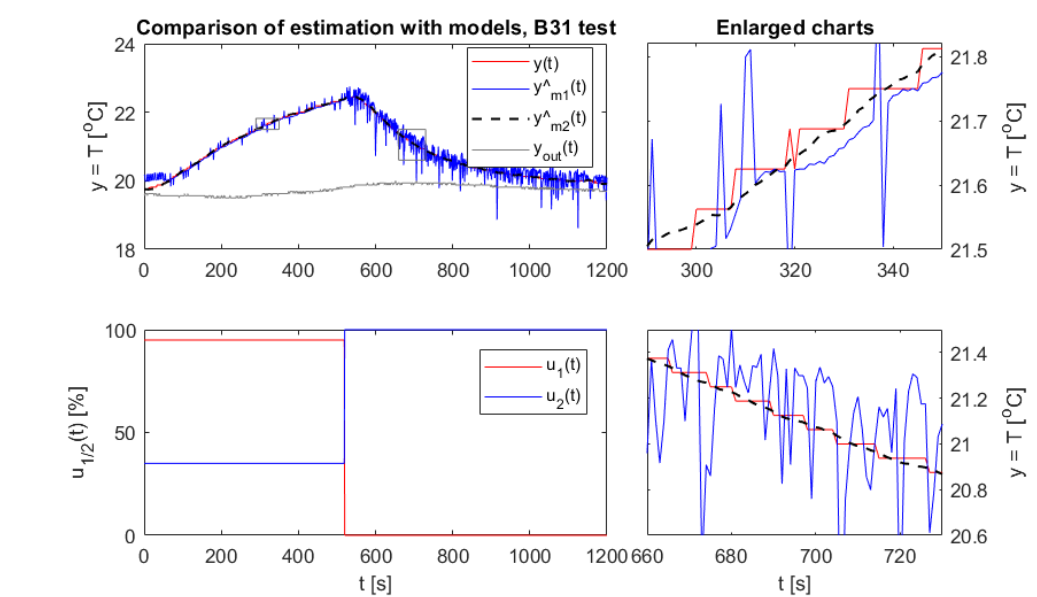
Figure 8. Experimental results for 100 particles; plots of the measured value (red), estimated values from assumed models (blue and black), and outdoor measurement (gray); and the input